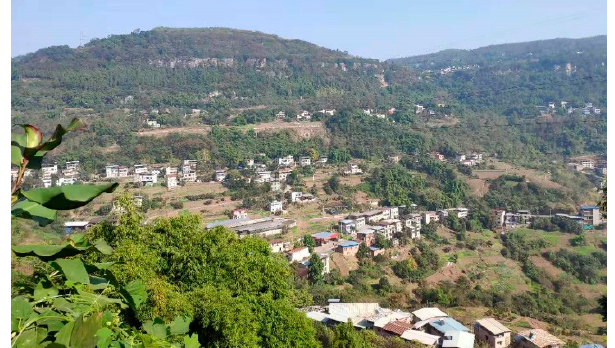
Figure 7. Scene photo.